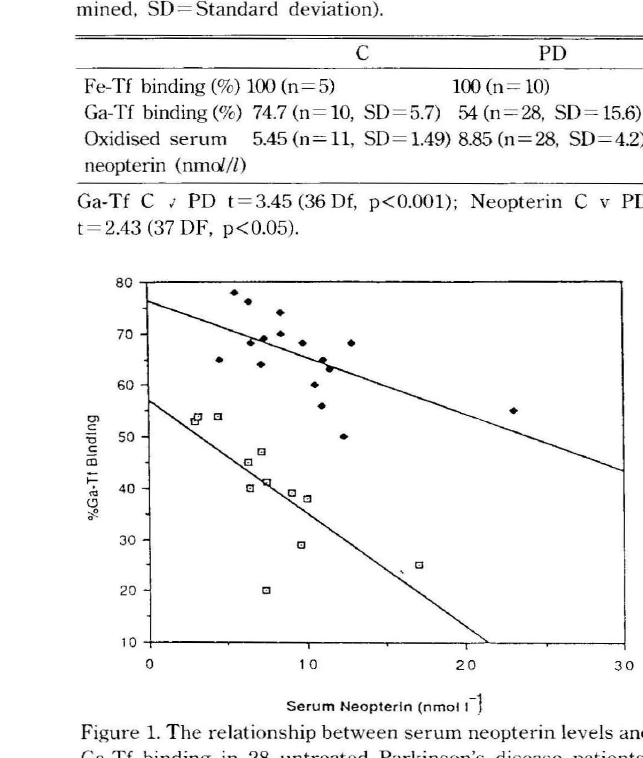
Table 1. Serum neopterin and binding of Fe and Ga to Tra nsferrin in samples of control plasma (C) and plasma from Parkinson's disease (PO) patients (n = number of patients exa mined, SD = Standard deviation).